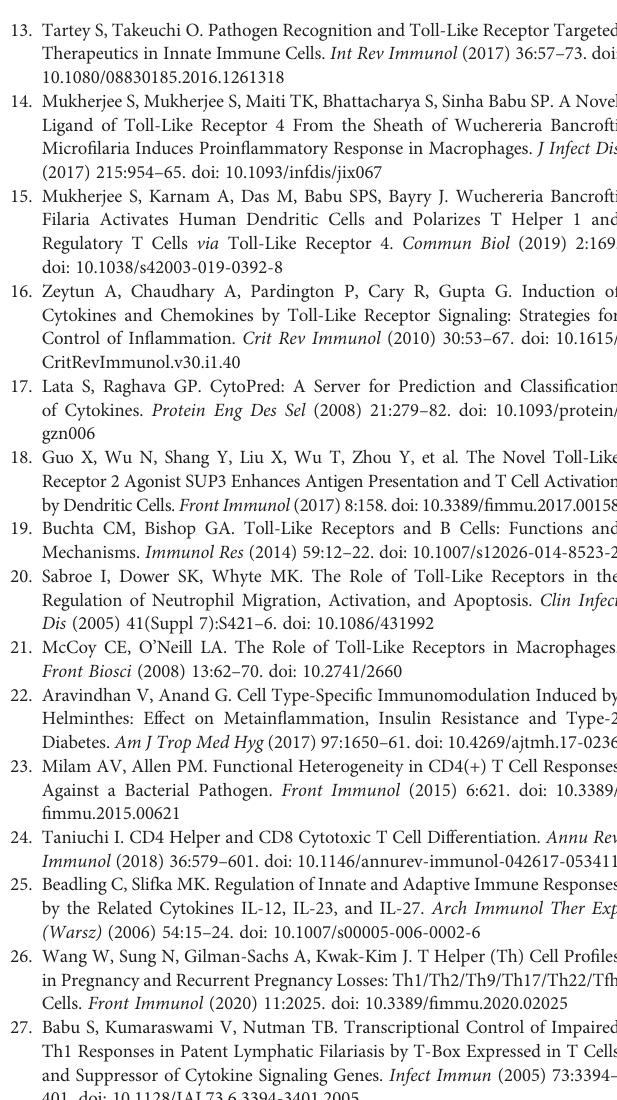
Supplementary Figure 2 | Gating strategy used for analysis of T helper cell subtype analysis. FSC vs SSC plot showing the gated lymphocyte population (A) . FSC-A vs FSC-H plot showing gated single cells of lymphocytes (B) . CD3 vs CD4 plot showing the gated CD3+CD4+ T helper cells (C) . IFN-y Vs IL-4 plot showing the gated Thl and Th2 population (E) . IL-9 Vs IL-17 plot showing the gated Th 17 and Th9 population (F) . Supplementary Figure 3 | Effect of diabetes on the TLR induced expression of MHC and costimulatory molecules in LF+ subjects. Supplementary Figure 4 | Effect of diabetes on expression of Th master regulators and immunomodulatory enzymes in LF+